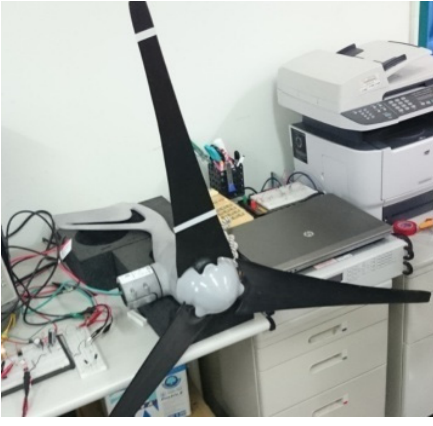
Figure 1. The AIR X wind